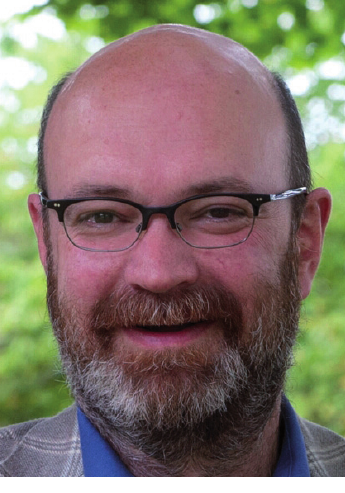
Figure 1 Volkhard Krech